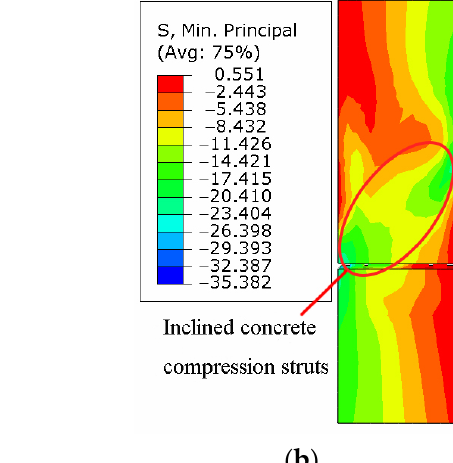
state: ( a ) RS connection; ( b ) RT